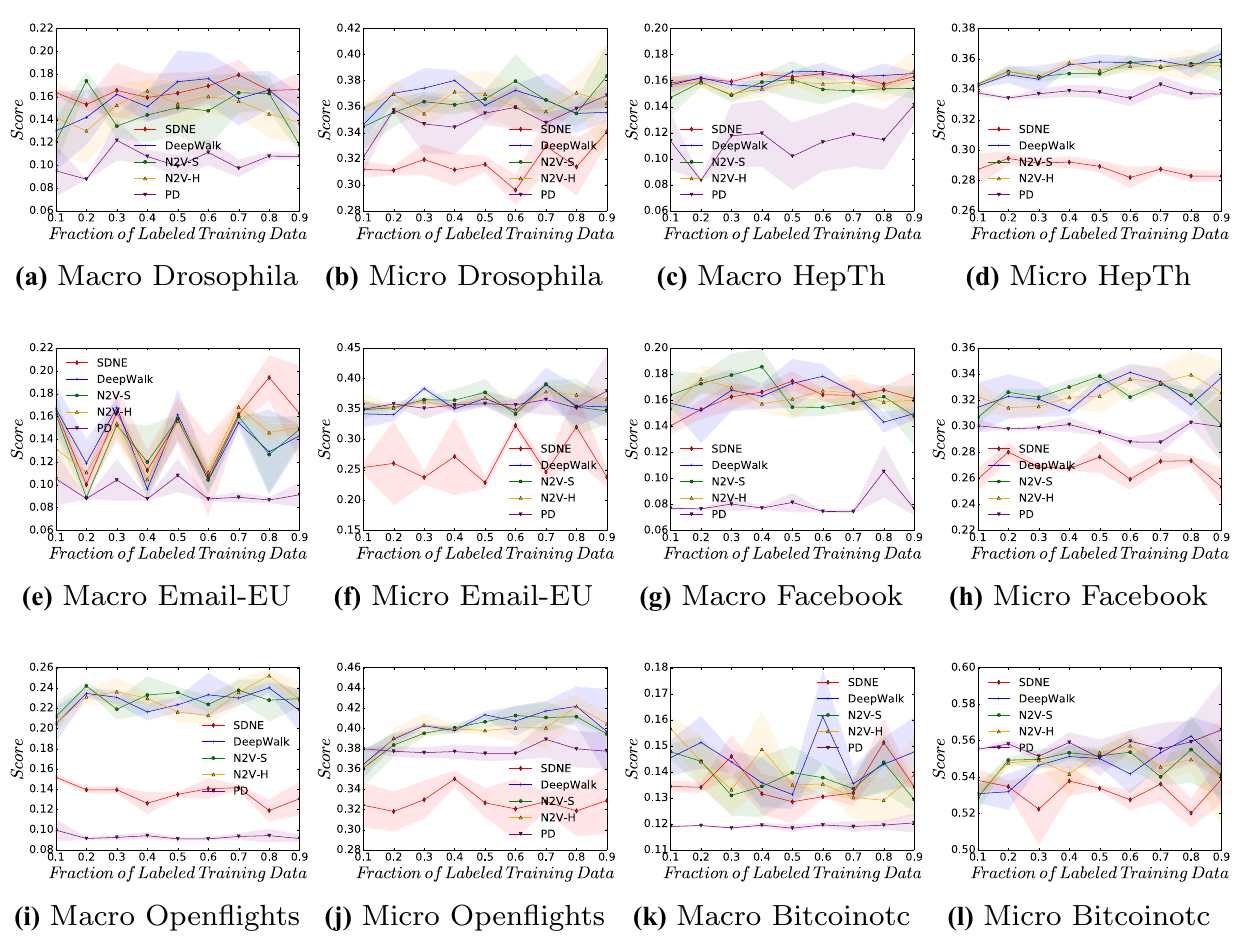
Fig. 4 Micro- and macro-f1 scores, across a range of labelling fractions, for all approaches when predicting a vertex’s triangle count (TR) value across all